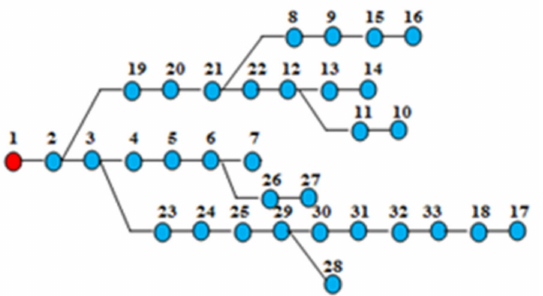
Figure 6. Optimal configuration for the minimization of the ENS criterion (open branches: 7-9-14-16-27).